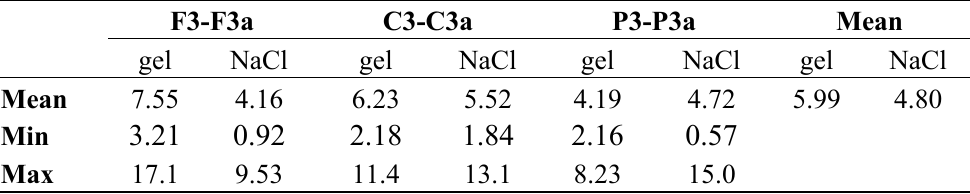
Table 5. RMS error (microvolt) in the time domain between the three pairs of textile electrode Type II and standard electrodes using gel and NaCl, respectively (standard electrodes are denoted with an “a” after the channel name). To the right the grand average is